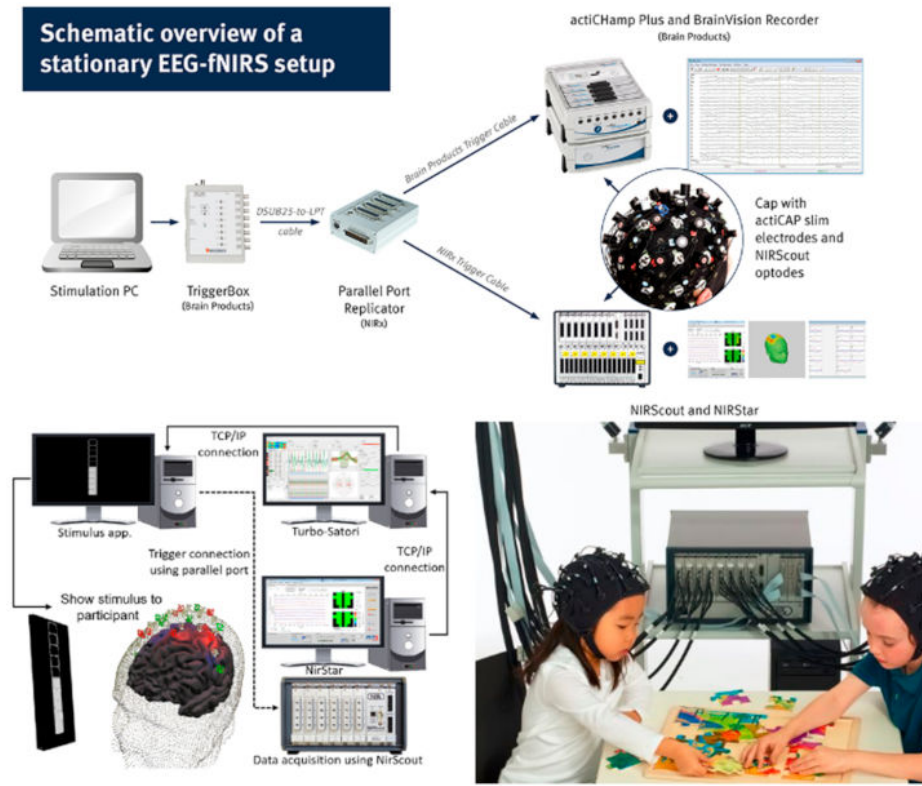
Figure 3. Schematic overview of a stationary EEG–fNIRS setup. (Reprinted with permission from